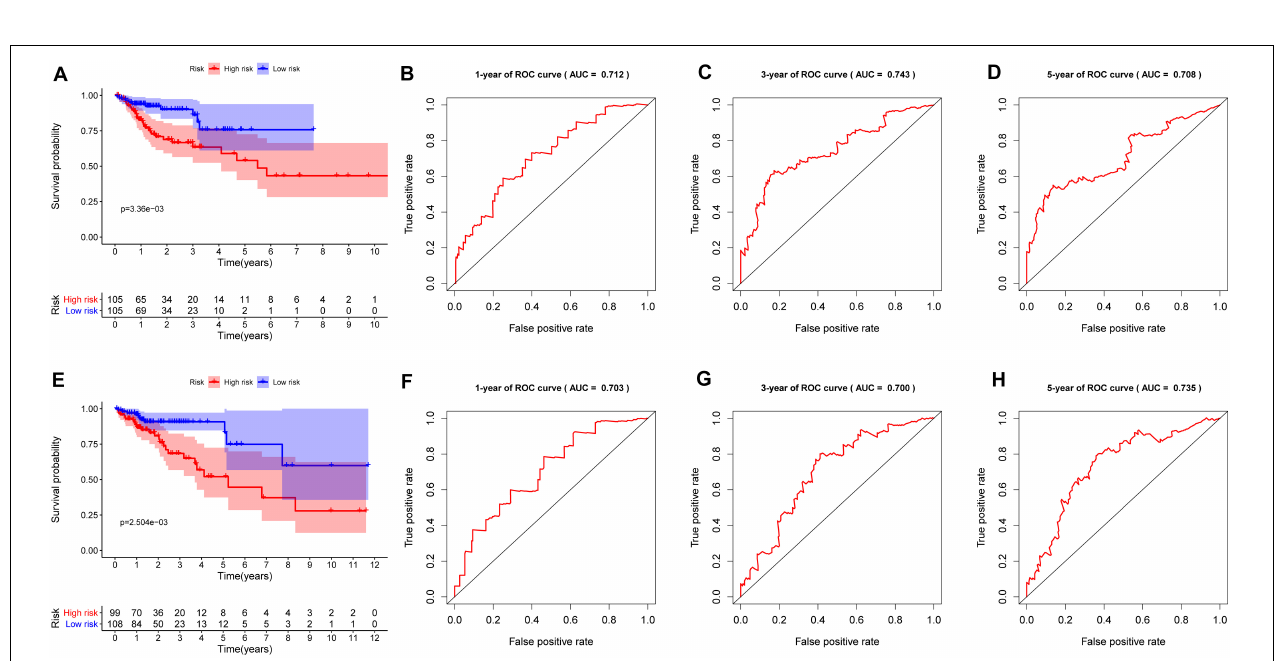
FIGURE 4 | Construction of an RBP-related risk signature and validation of the prognostic value in the testing set. (A) Heatmap of the seven-RBP expression profiles in the high- and low-risk groups for the training set. (B) The seven RBPs-based risk score distribution in the training set. (C) Distribution of the risk score based on the seven-RBP signature for patient survival status in the training set. (D) Heatmap of the seven-RBP expression profiles in the high- and low-risk groups for the testing set. (E) The seven RBPs-based risk score distribution in the testing set. (F) Distribution of the risk score based on the seven-RBP signature for patient survival status in the testing set.